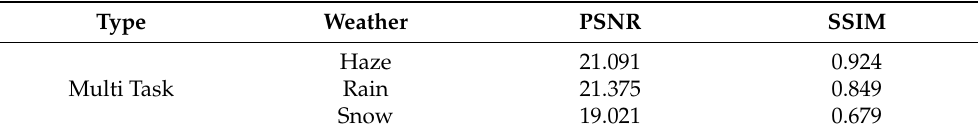
Figure 8. Application of MTWG on Foggy Cityscapes using SOTA pedestrian detector. Table 4. Generation Results on Cityscapes